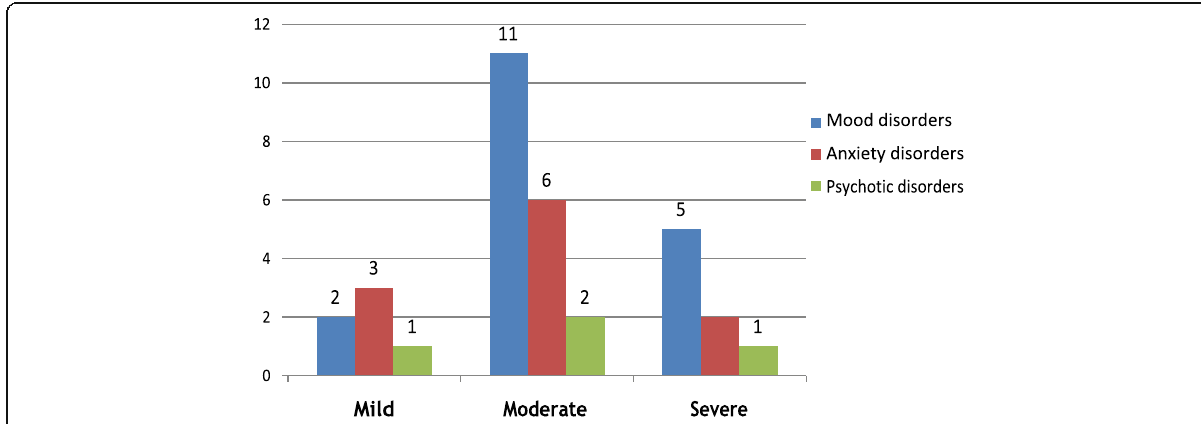
Fig. 6 Relationship between severity of dependence and the presence of specific psychiatric